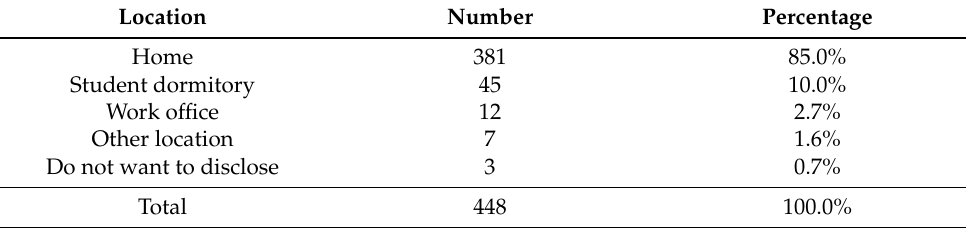
Table 4. Regular location of students with work experience.